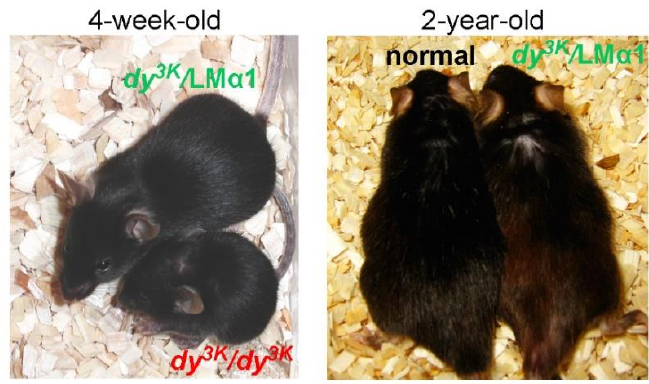
Figure 2. An example of a rescue of dystrophic phenotype in a mouse model for congenital MD. The mouse lacking laminin α2 chain ( dy 3K /dy 3K in the left picture ) at the terminal stage of the disease shows severe muscle wasting and severe overall phenotype. The laminin α2 chain-deficient littermate overexpressing laminin α1 chain ( dy 3K / LMα1) displays significant improvement of multiple aspects of the disease. The laminin α1 transgene prevents MD throughout life ( right picture ): two-year-old dy 3K / LMα1 and normal littermate mouse present similar outward features.